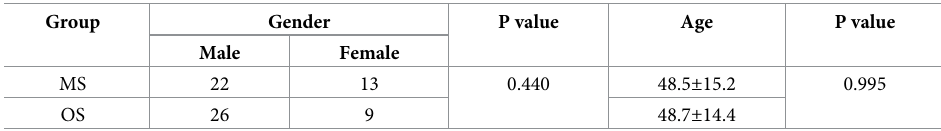
Table 1. The patient demographic data.